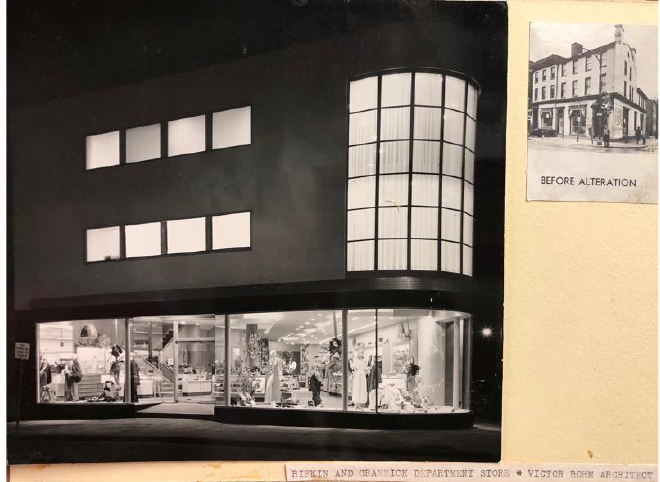
Figure 20. Rifkin and Grannick, Trenton, New Jersey, 1947. Source: Linda Bohm’s personal ar- chive.